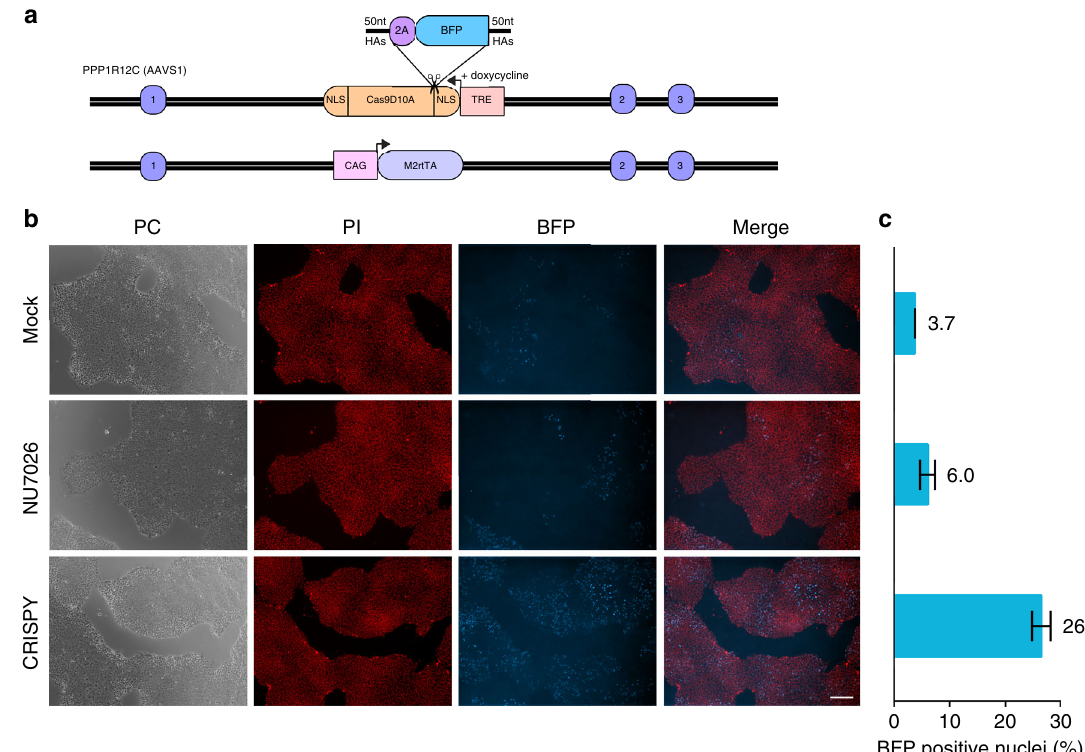
Fig. 4 Impact of the CRISPY mix on gene fragment insertion ef fi ciency in iCRISPR hiPSCs. Shown is the insertion ef fi ciency of a gene fragment coding for a blue fl uorescent protein (BFP) in the heterozygous AAVS1 iCRISPR locus using a single-stranded DNA donor in 409-B2 iCRISPR-Cas9n hiPSCs. The design of the mtagBFP2 30 ssODN donor and the iCRISPR system is shown in a . We inserted a 871 nt (including 50 nt homology arms) sequence coding for a 2A- self cleaving peptide in front of a blue fl uorescent protein (BFP), directly after the N-terminal nuclear localization signal sequence (NLS) of the Cas9n in the heterozygous AAVS1 iCRISPR locus 13 . If the sequence is inserted, doxycycline will lead to expression of nucleus-imported BFP. Representative images of the mock, NU7026, and CRISPY mix treatment, after 7 days of BFP expression are shown in b as phase contrast (PC), propidium iodide nuclei staining (PI), mtagBFP2 expression (BFP), and merge of PI and BFP. Two images (× 50 magni fi cation, white size bar 200 µ m) from each of three technical replicates for the respective treatments were used to quantify the percentage of cells with BFP insertion using ImageJ ( c